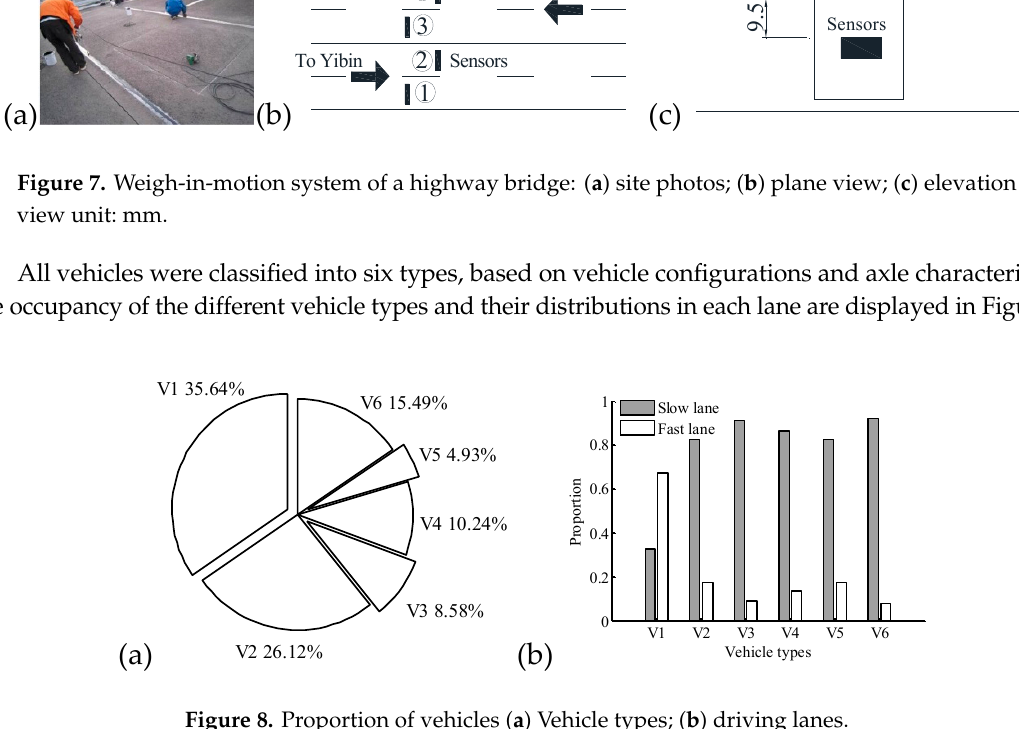
Figure 8. Proportion of vehicles ( a ) Vehicle types; ( b ) driving lanes.